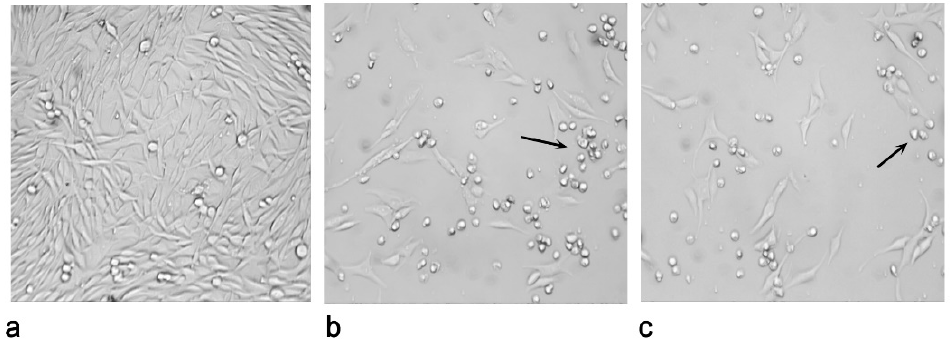
Figure 3. C32 cells morphology 48 h after UVA irradiation at a dose of 1.08 J/cm 2 . ( a ) Control, irradiated cells in RPMI 0.5% MeOH, without sample; ( b ) irradiated cells, C. sicula L. obtained with Naviglio extractor ® , 25 μ g/mL; ( c ) irradiated cells, C. libanotis L. extracted through Naviglio extractor ® , 25 μ g/mL. Cells were visualized with an inverted microscope AE20 Motic and images were captured with a VisiCam digital camera. Arrows show cells became rounded and shrunken. Magnification, 10×.